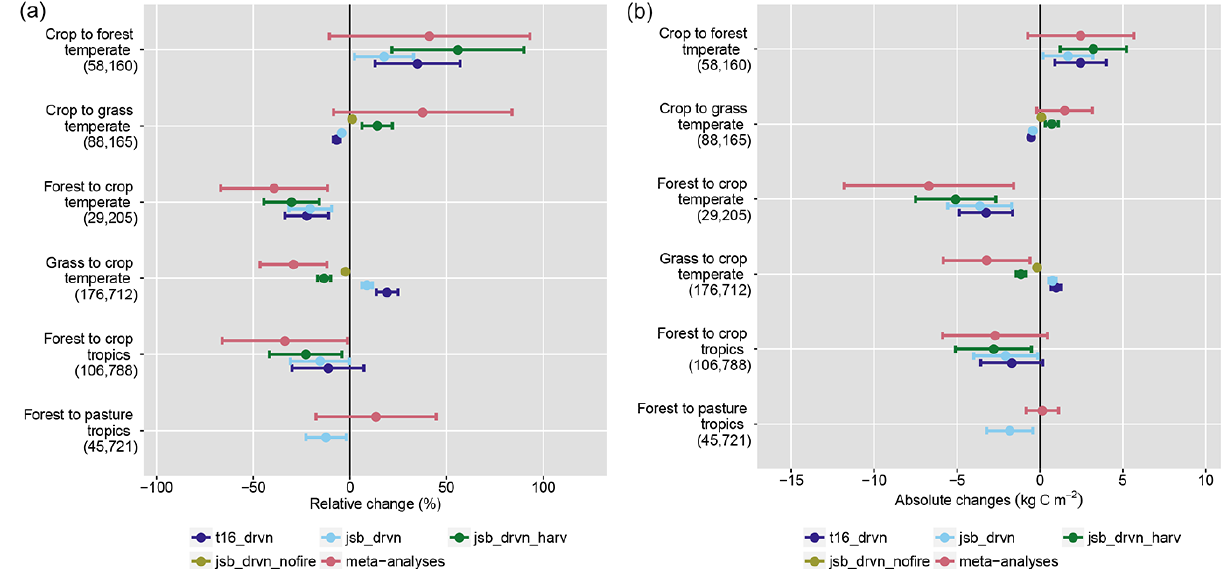
Figure 2. Mean simulated relative (a) and absolute changes in soil carbon (b) over the sampled ages represented by the meta-analyses compared to results from the meta-analyses. The first number in the parenthesis represents the number of studies in the meta-analyses and the second is the number of grid cells fulfilling the climate criterion in the meta-analyses (regions in Fig. S1). The dots represent the mean changes, and the bars represent the standard